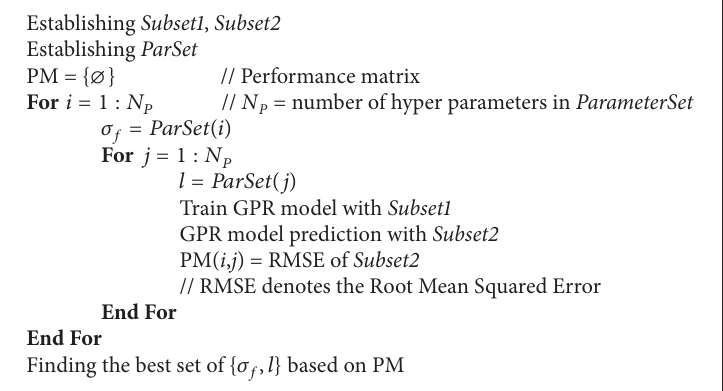
Algorithm 1: Grid search procedure for GPR hyperparameter determination.